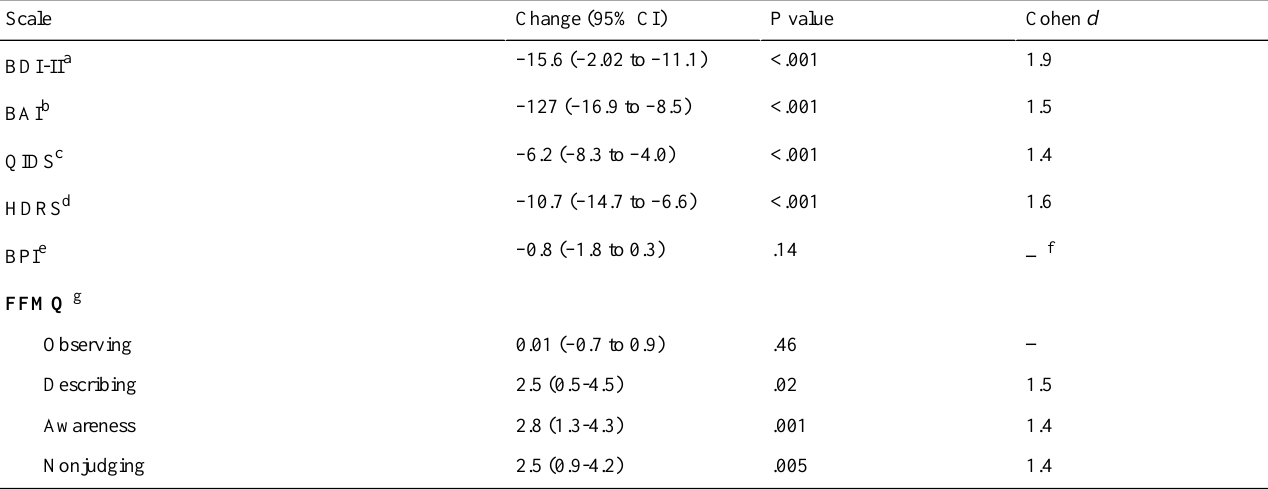
Table 3. Within-group differences of intervention participants who completed the trial